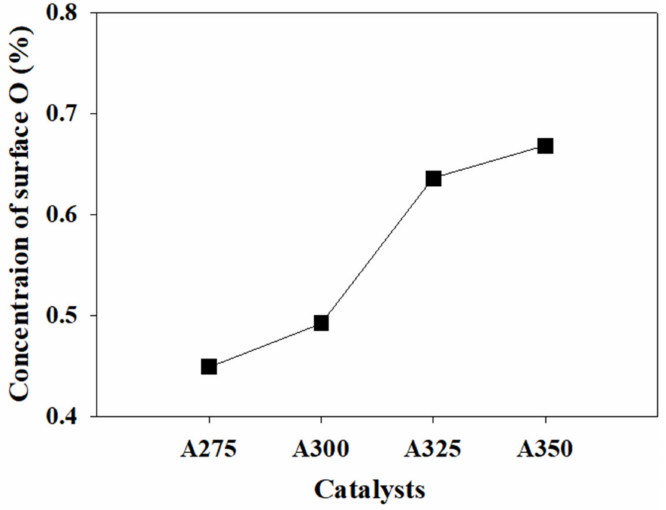
Figure 9. Concentration of surface O as a function of catalyst synthesis temperature, drawn from the XPS data (Table